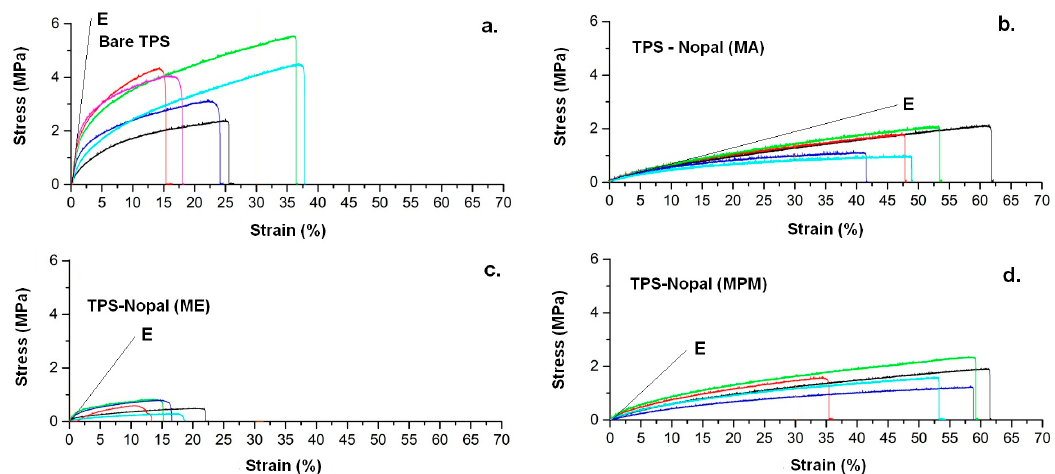
Figure 7. Tensile curves of thermoplastic starch (TPS) (a.) and its blended films with nopal mucilage (MA film (b.), ME film (c.), MPM film (d.)). Colors represent the curves for the different samples tested.